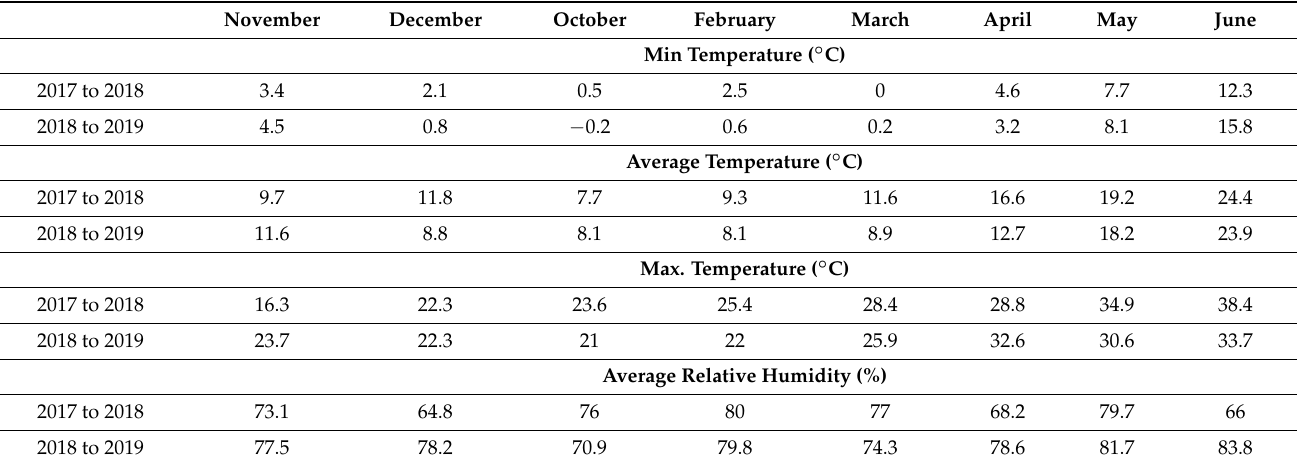
Table 1. The average monthly temperature and relative humidity values in the first and second growing seasons.